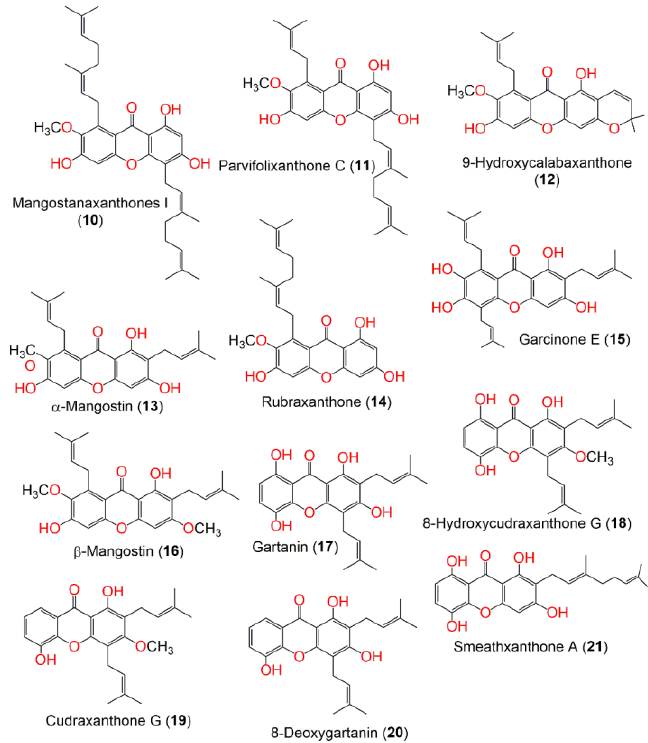
Figure 2. Structures of compounds 10 – 21 .